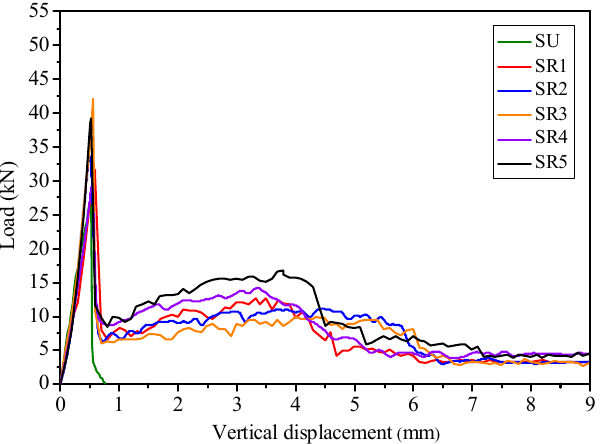
Figure 10. Load-vertical displacement curve of the pervious concrete beams with small-size aggregates.